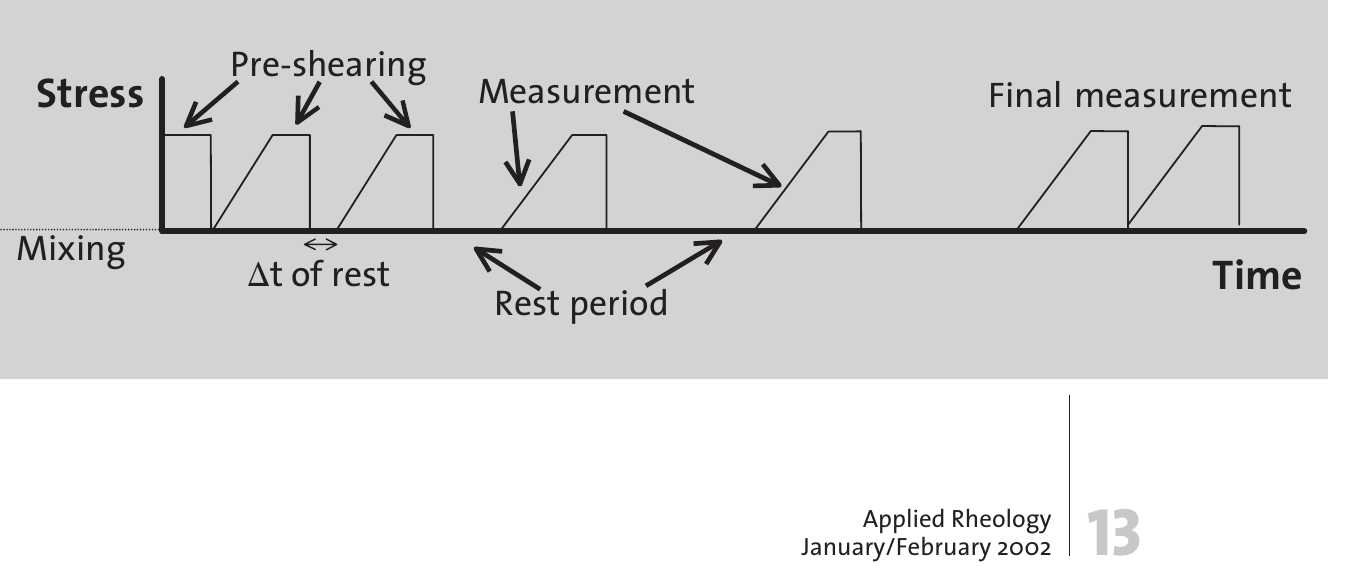
Figure 1: Protocol of the measurement of the grout